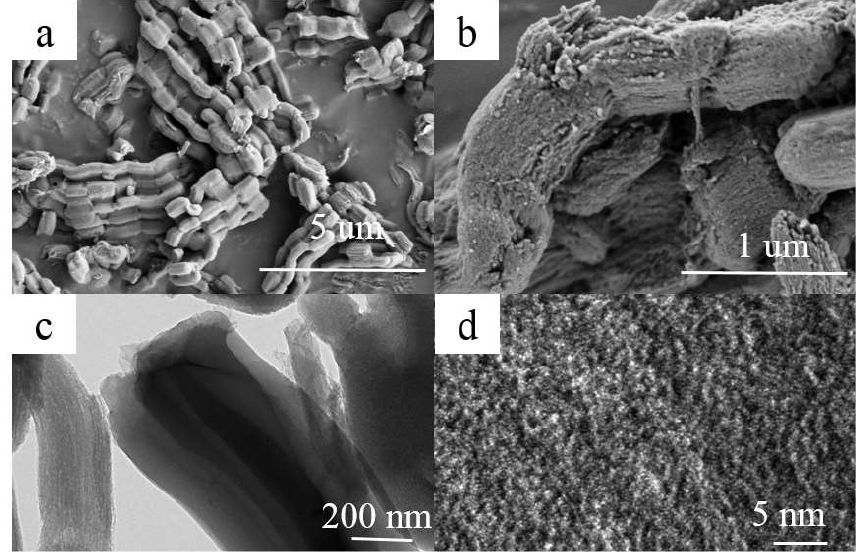
Nanomaterials 2019 , 9 , x FOR PEER REVIEW Figure 3. SEM (a,b)and TEM(c,d) images of A-CMK-3. Figure 3. SEM ( a , b ) and TEM ( c , d ) images of A-CMK-3.